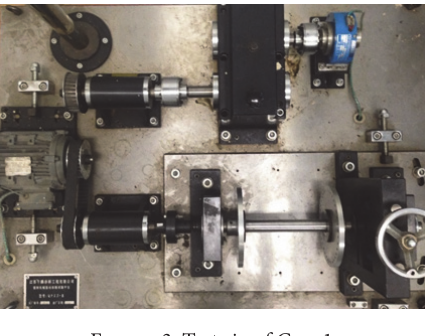
Figure 3: Test rig of Case 1.